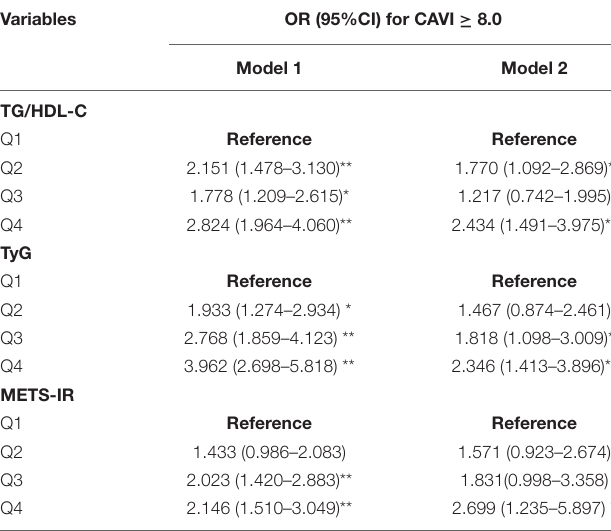
TABLE 5 | Logistic regression analyses for the association between non-insulin-based IR indices and a CAVI ≥ 8.0. Variables OR (95%CI) for CAVI ≥